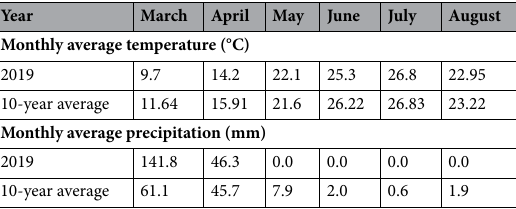
Table 1. Weather data from March to August 2019 at the study site in Mahabad,